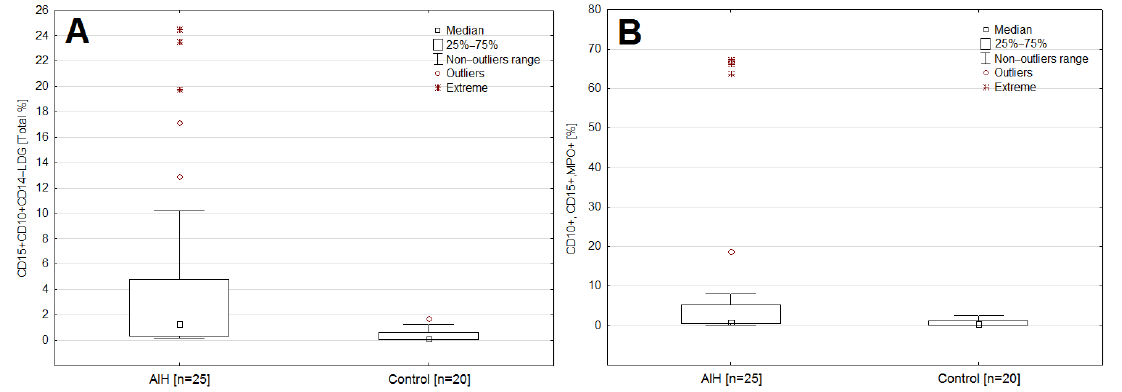
Figure 4. Box-whisker plot comparing the percentage of LDG ( A ) and the LDG fraction ( B ) showing MPO expression in the AIH group and the control group.